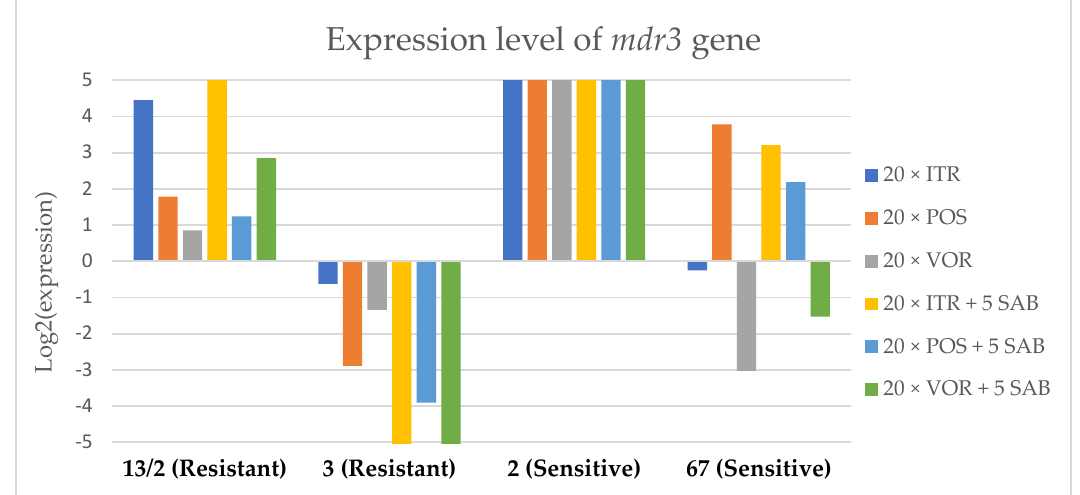
Figure 5. Expression levels of mdr3 after culturing isolates on SAB with ITR, POS and VOR additions,